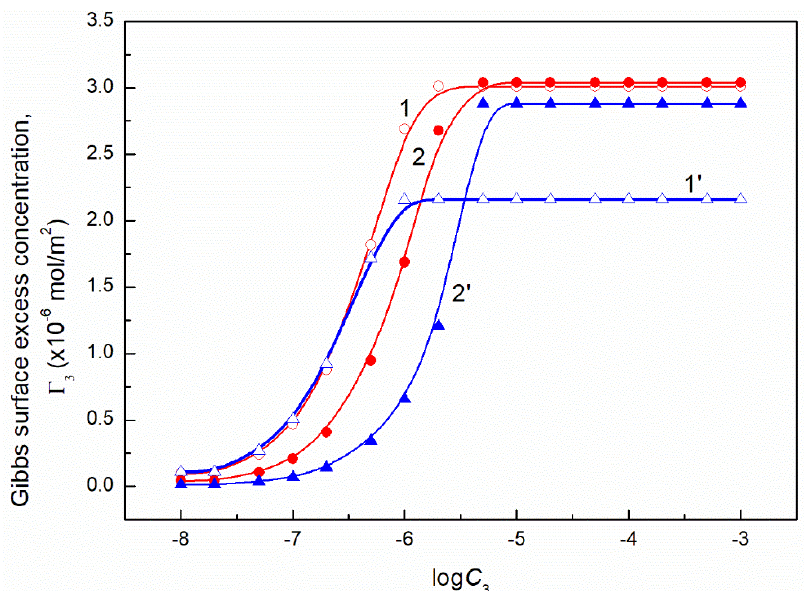
Figure 13. A plot of the Gibbs surface excess concentration of FC1 ( Γ 3 ) calculated from Equation (9) based on the measured surface tension of the ternary mixture at the constant concentration of the CTAB + TX100 at γ LV equal 60 mN/m (curve 1) and 50 mN/m (curve 2) and on the contribution of FC1 to the reduction of water surface tension (curve 1’corresponds to γ LV = 60 mN/m and curve 2’corresponds to γ LV = 50 mN/m) vs. the logarithm of the FC1 concentration ( logC 3 ).